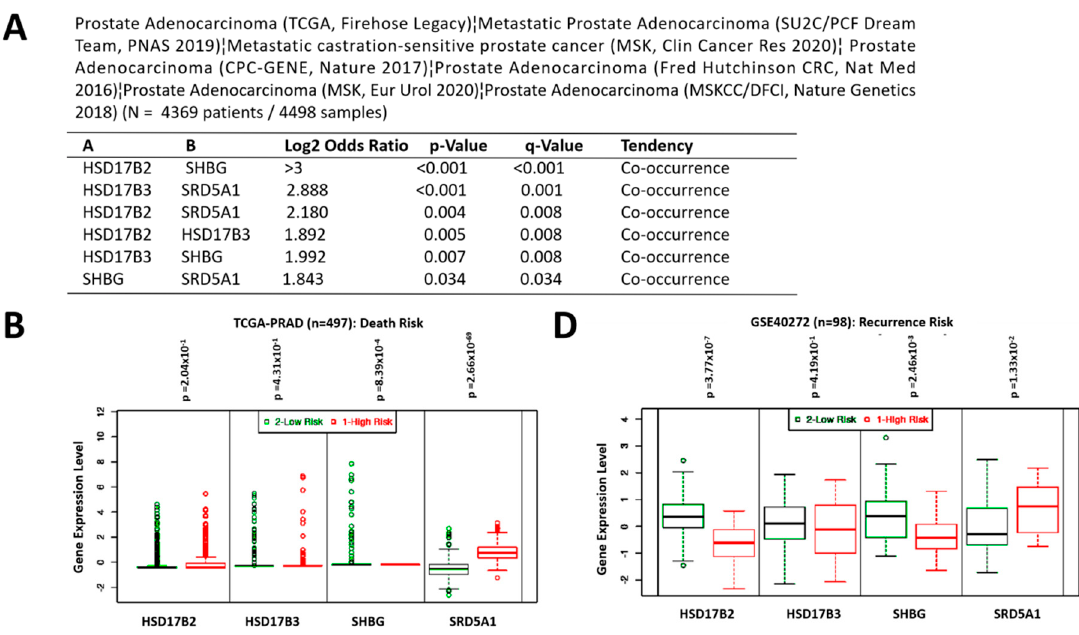
Figure 2. Variation in HSD17B2, HSD17B3, SHBG, and SRD5A1 expression co ‐ occur and concertedly bear significant prog ‐ nostic relevance in patients with PCa. ( A ) Depiction of mutual exclusivity or co ‐ occurrence analysis using a multi ‐ source pooled primary and metastatic PRAD cohort (N = 4369 patients/4498 samples). ( B ) Graphical representation and ( C ) heatmap of the association between HSD17B2, HSD17B3, SHBG, or SRD5A1 gene expression and death risk in the TCGA PRAD cohort. ( D ) Graphical representation and ( E ) heatmap of the association between HSD17B2, HSD17B3, SHBG, or